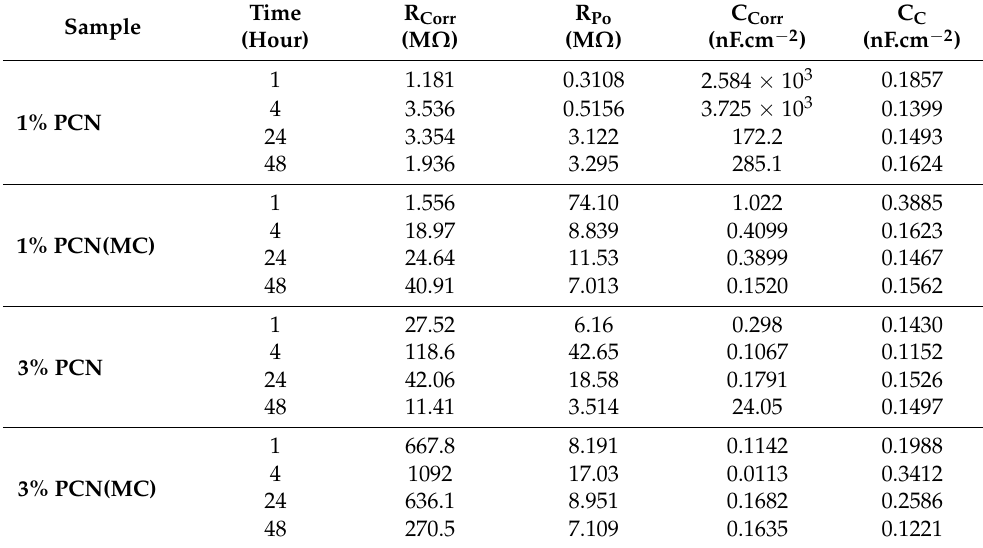
Table 6. EIS fitted data of 1% PCN, 3% PCN, 1% PCN (MC) and 3% PCN (MC) after immersion